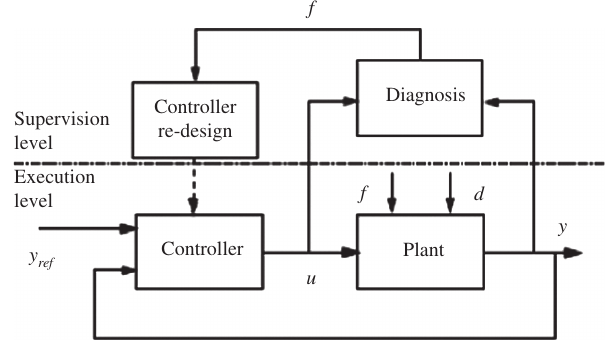
Figure 8. Structure of the Fault Tolerant Control